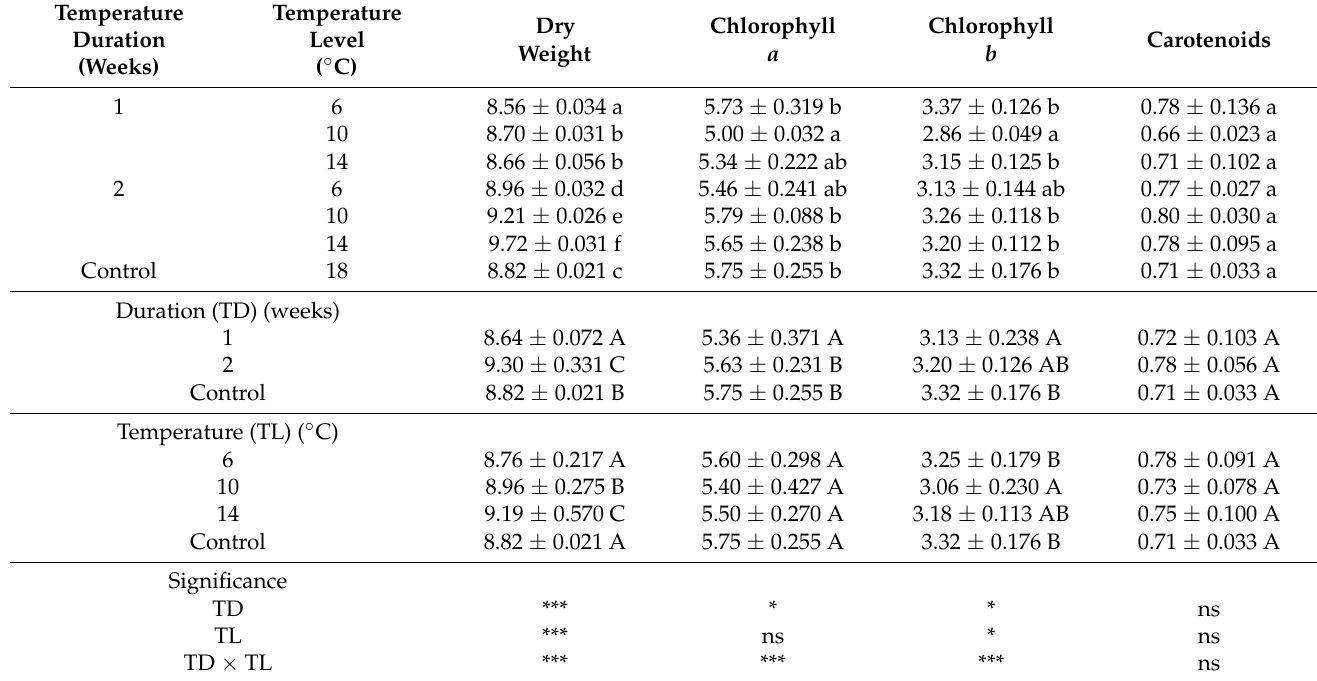
Table 4. Effect of low-temperature treatment of the seedlings on dry weight (g 100 g − 1 FW), chlorophylls, and carotenoids (mg 100 g − 1 FW) contents of broccoli